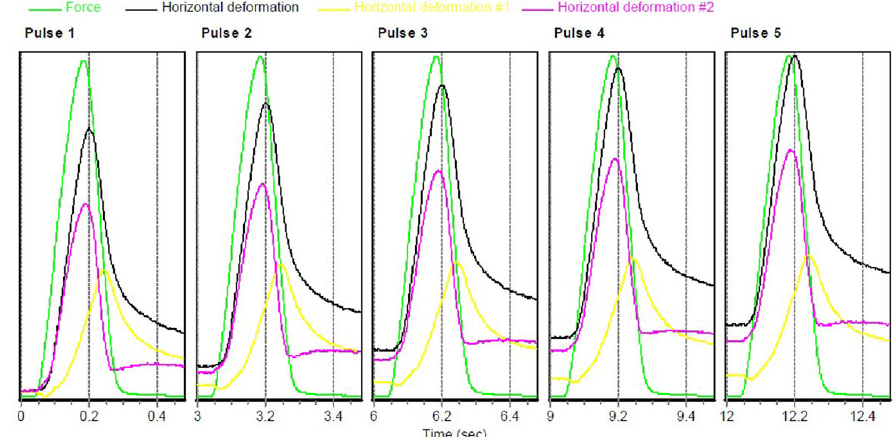
Fig. 2. Loading scheme in ITSM